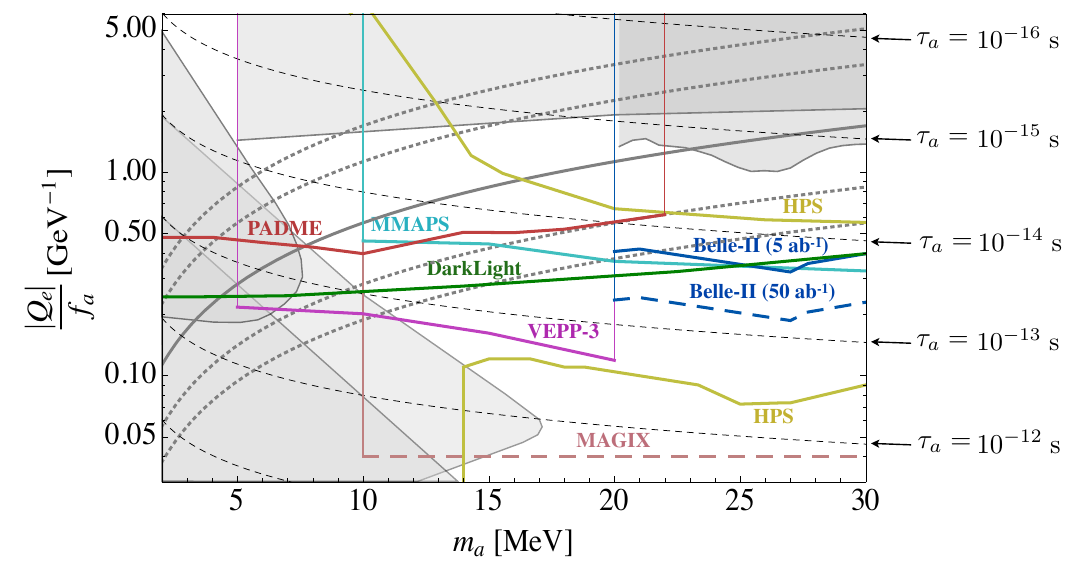
Figure 2 . Projected reach of several planned dark photon experiments into the MeV axion param- eter space, based on [151]. Gray curves and gray shaded areas are from (cid:12)gure